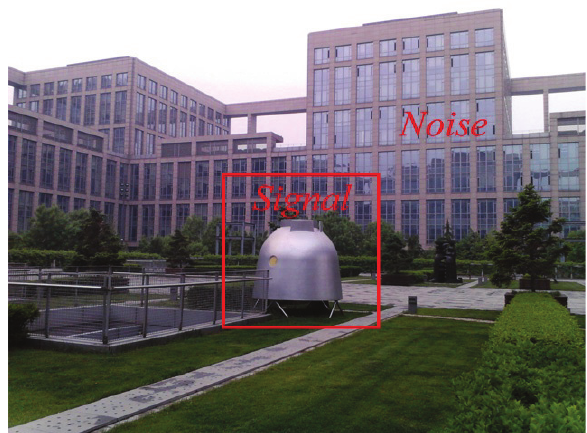
Fig. 2. Measure of Signal and Noise . In this training image, our target is inside the red rectangle and background outside the red rectangle. Signal and Noise are the normalized saliency of the region of target and background,